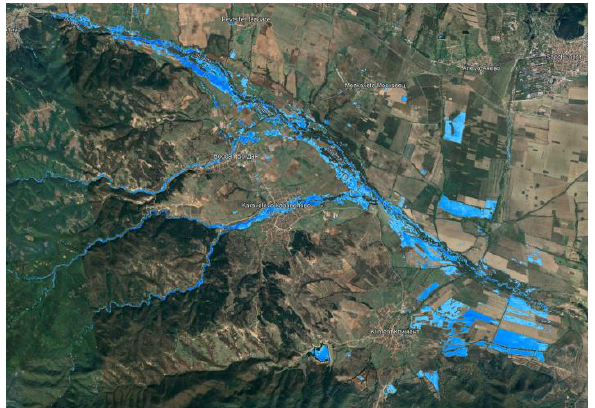
Figure 15. Flooded